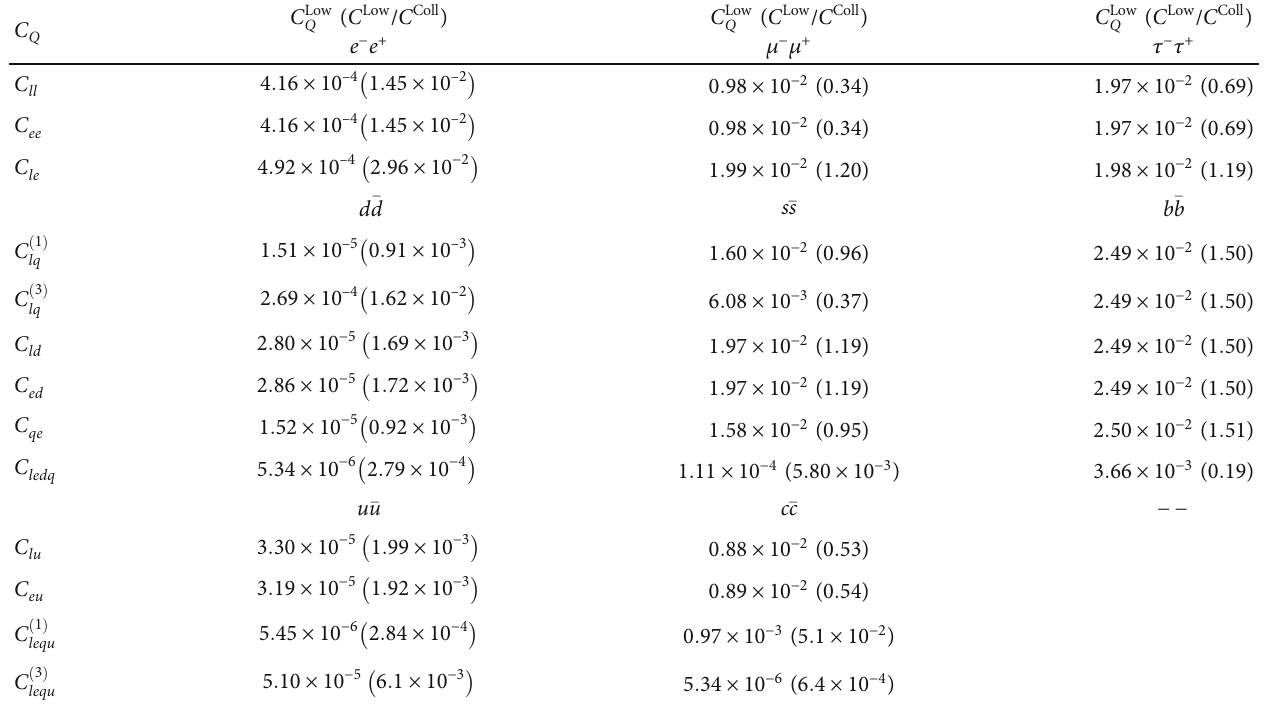
used by [28] instead of the Λ = 4 TeV scale adopted in this study. t = 100, E μ = 3000 e